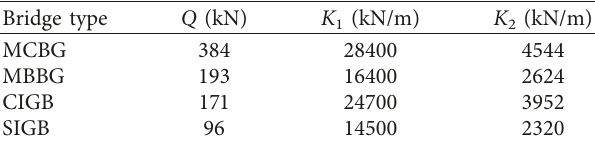
Table 4: Mechanical properties of LRB of the four bridge